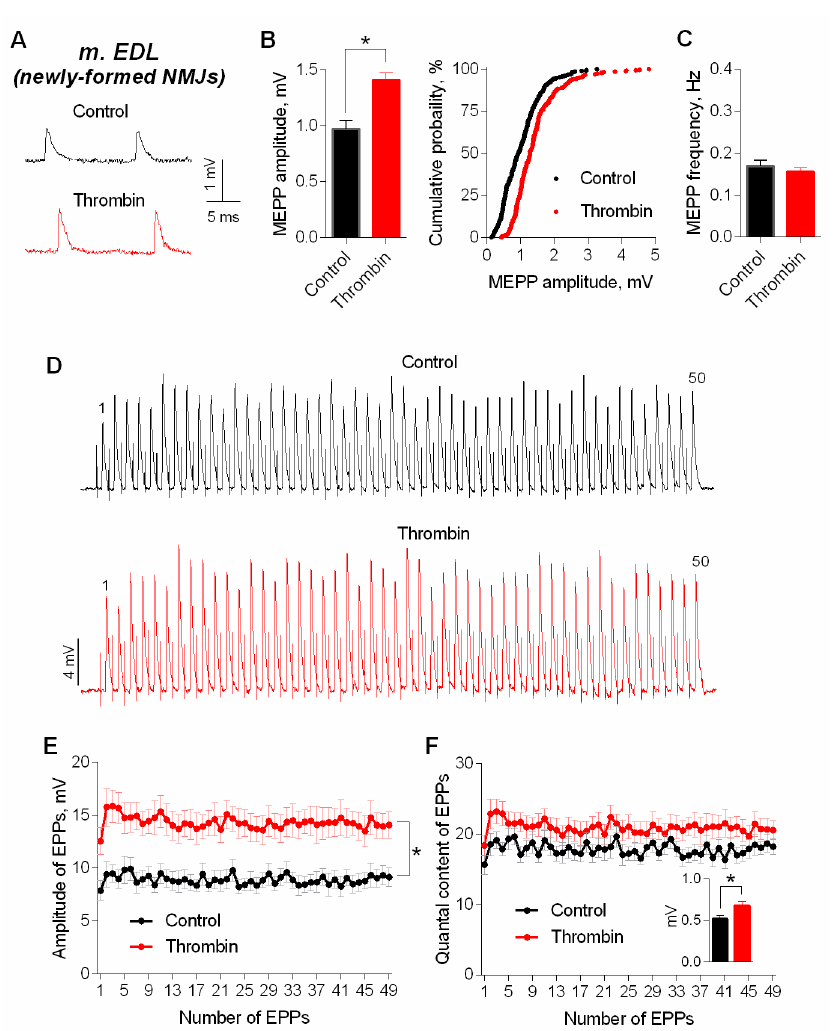
Figure 1. Thrombin in low concentration (1 nM) increases amplitudes of spontaneous and evoked postsynaptic endplate potentials at newly-formed NMJs of reinnervated mouse m. EDL. ( A ) Representative recordings of MEPPs in control (above) and upon application of thrombin (below). ( B ) Mean amplitude of MEPPs (left) and cumulative probability plots (right) in control ( n = 29) and upon application of thrombin ( n = 31). ( C ) Mean frequency of MEPPs in control and in the presence of thrombin. ( D ) Representative recordings of EPPs during a short (1 s) high-frequency (50 Hz) train in control (above) and upon application of thrombin (below). ( E ) Changes in the EPP amplitude in control ( n = 16) and in the presence of thrombin ( n = 16). ( F ) Quantal content of EPPs in control and upon application of thrombin. Inset shows MEPP amplitudes. Histograms, symbols (except the ones in cumulative probability plots) and error bars represent the mean ± SEM. * p < 0.05 compared to control.